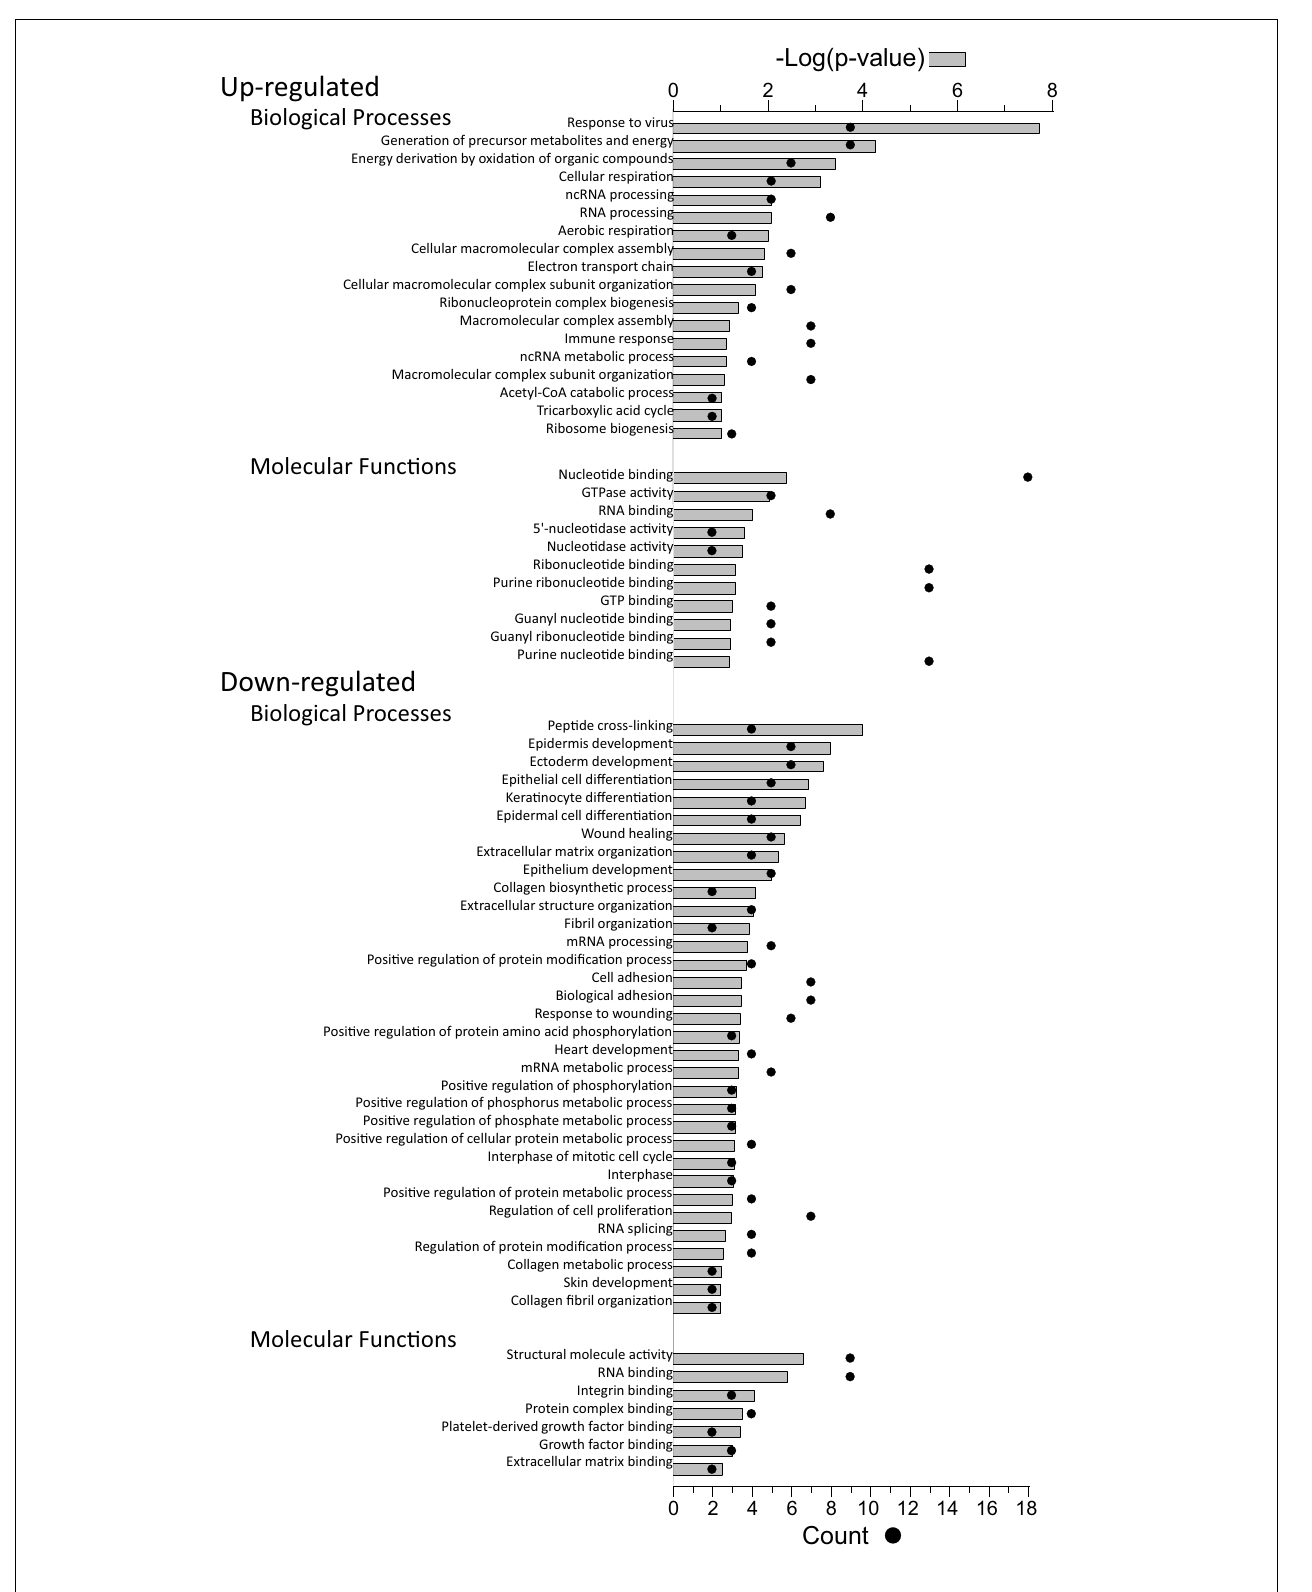
gene ontology suite of programs at the NIAID, gene identifications converted by that program, and ontological functions determined by